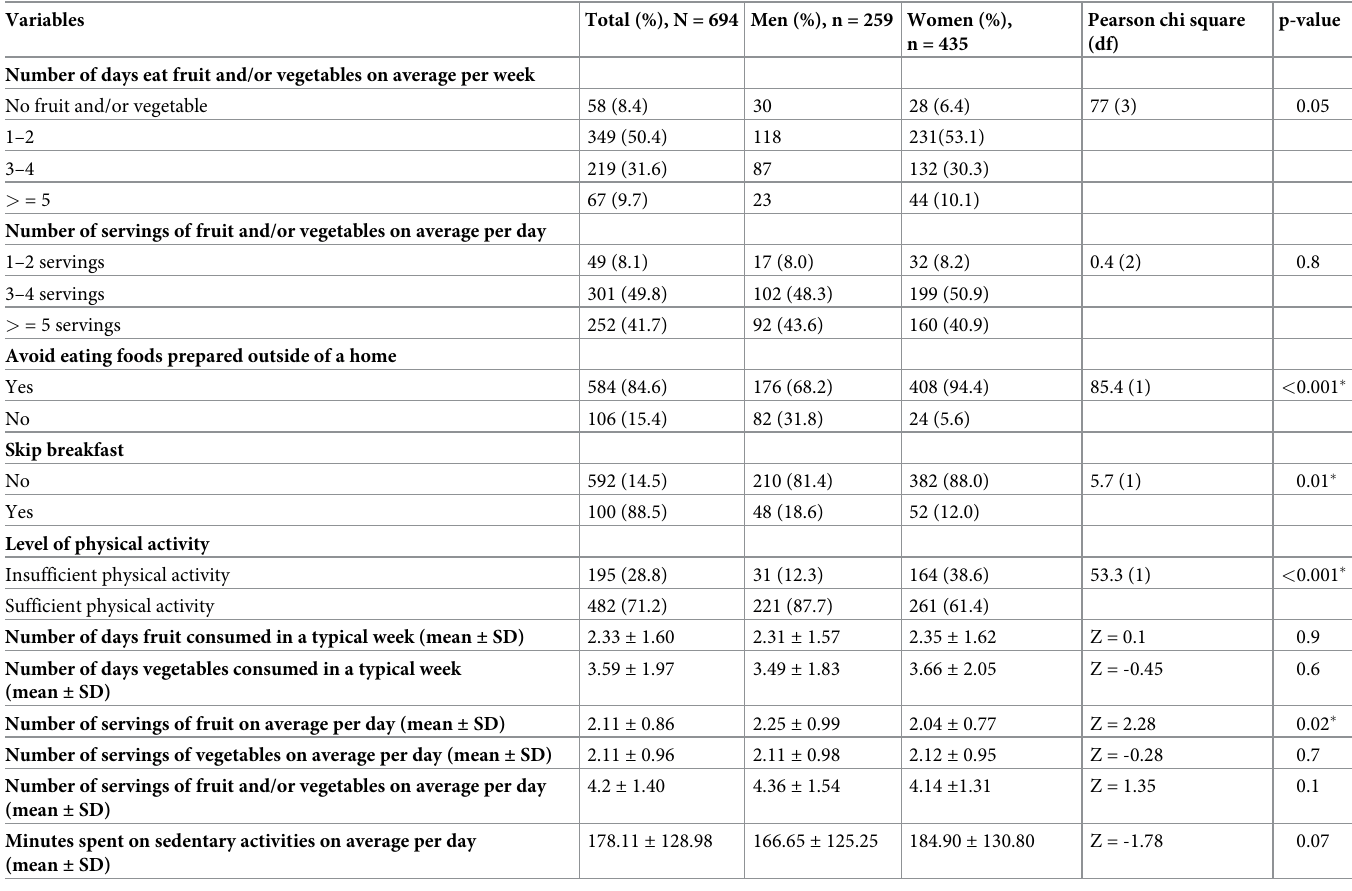
Table 2. Behavioral characteristics of study participants in administrative towns of Bale zone, Southeast Ethiopia, 2021.